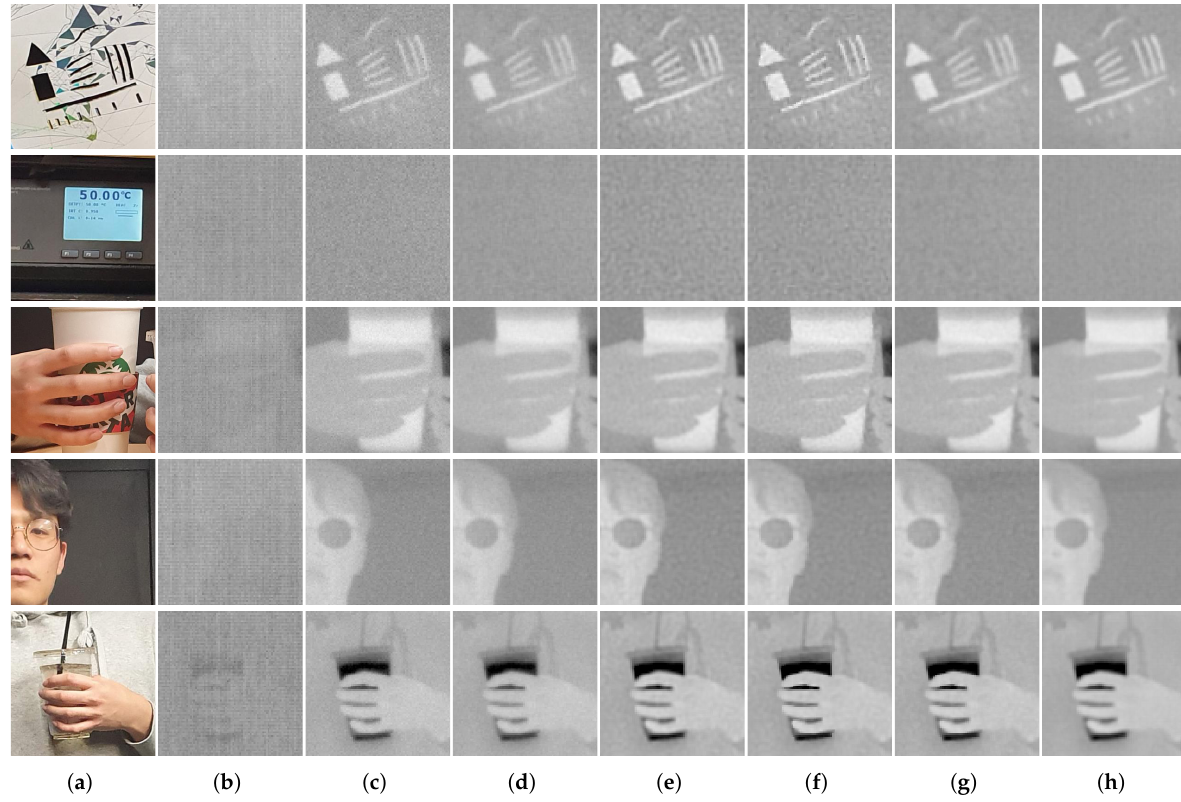
Figure 9. Thermal image deconvolution results of real-world infrared images restored by non-blind image deconvolution algorithms. ( a ) Visible-band image; ( b ) observed infrared image; ( c ) initially denoised image [14]; ( d ) Levin et al. [6]; ( e ) Liming et al. [8]; ( f ) Jon et al. [11]; ( g ) Lee et al. [10]; ( h )